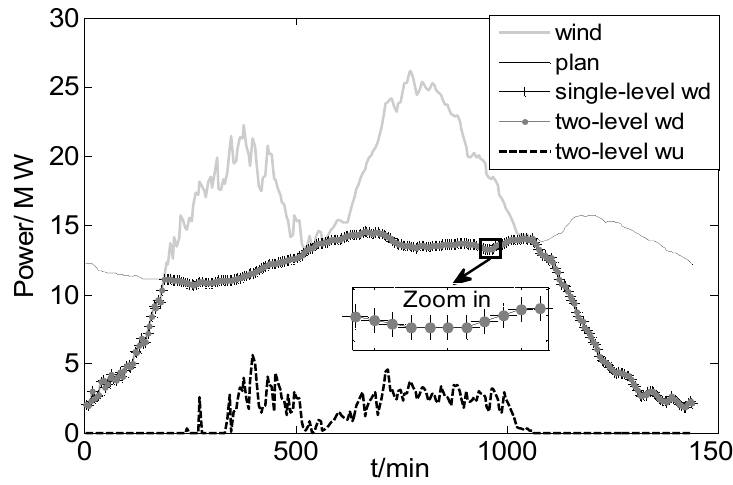
Figure 12. Simulation result for the third sub-objective after the exchange of w 2 and w 3 .